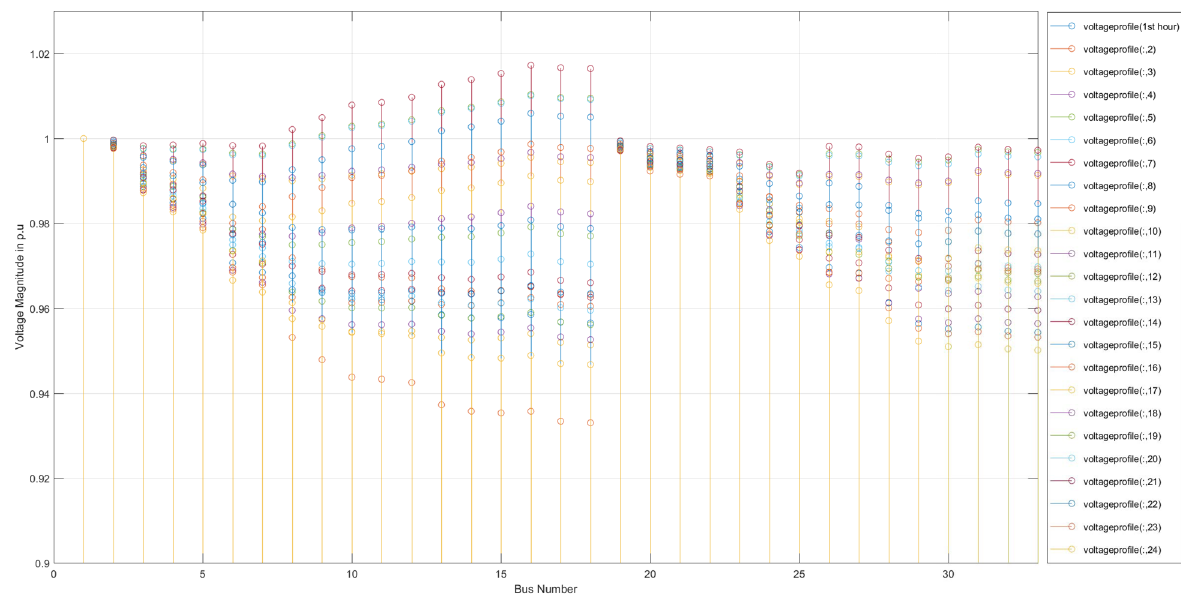
Fig. 7 Voltage profile of the test system after optima placement of DGs at upf by PSO